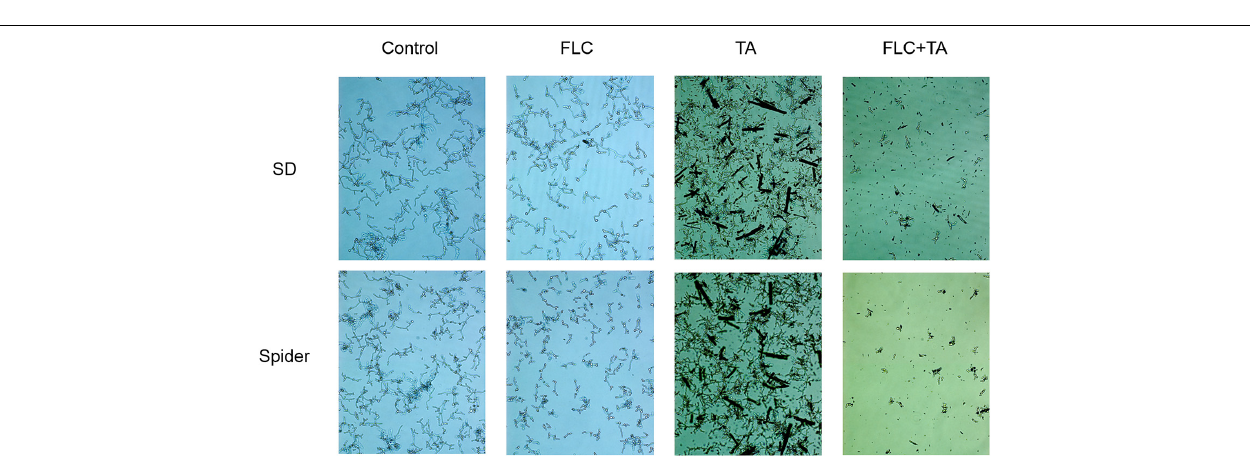
FIGURE 7 | Filamentation assay in a liquid medium. The SD and Spider mycelium induction medium significantly inhibited the growth of drug-resistant C. albicans CA23 hyphae in the combined administration group than in the control group (magnification; 400 ×